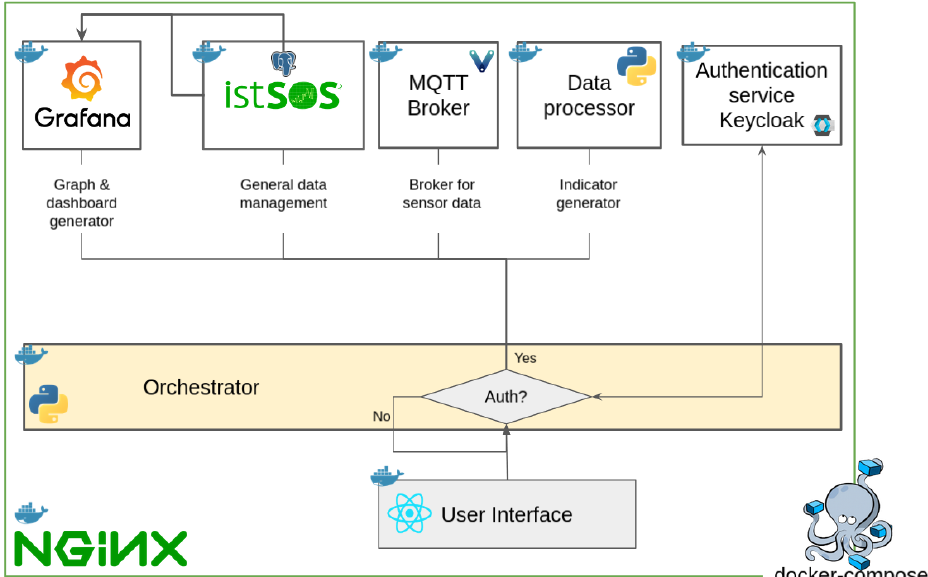
Figure 9. The system